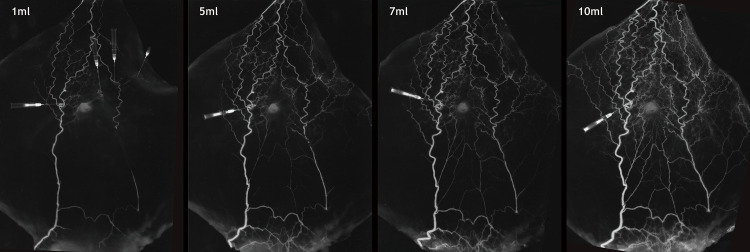
Serial venogram through the vena comitantes of the major perforator of the deep inferior epigastric artery.The venogram taken after 1 mL injection of barium shows midline crossover in the supraumbilical area. However, midline crossover began to gradually appear in the infraumbilical area with increases in the amount of injected barium.